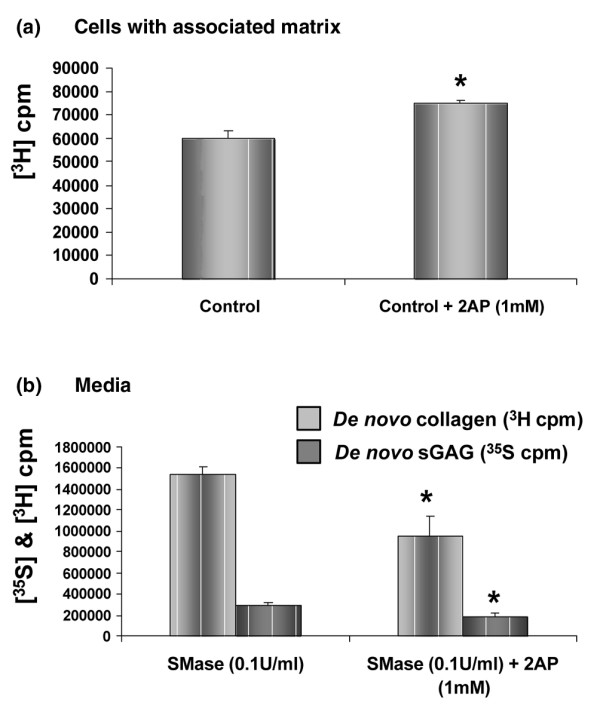
PKR is involved in cartilage matrix homeostasis. To determine whether PKR mediates the observed changes in chondrocyte matrix homeostasis, PKR activity was inhibited by adding 1 mmol/l 2AP to duplicate cultures. (a) Inhibition of PKR in untreated, control cells caused an increase in cell associated collagen. (b) Addition of 2AP to sphingomyelinase-treated cultures resulted in a significant reduction in the amount of de novo sGAG and collagen in the media. Data are presented as mean ± strandard error. * P < 0.05. 2AP, 2-aminopurine; cpm, counts/min; PKR, protein kinase R; sGAG, sulphated glycosaminoglycan.